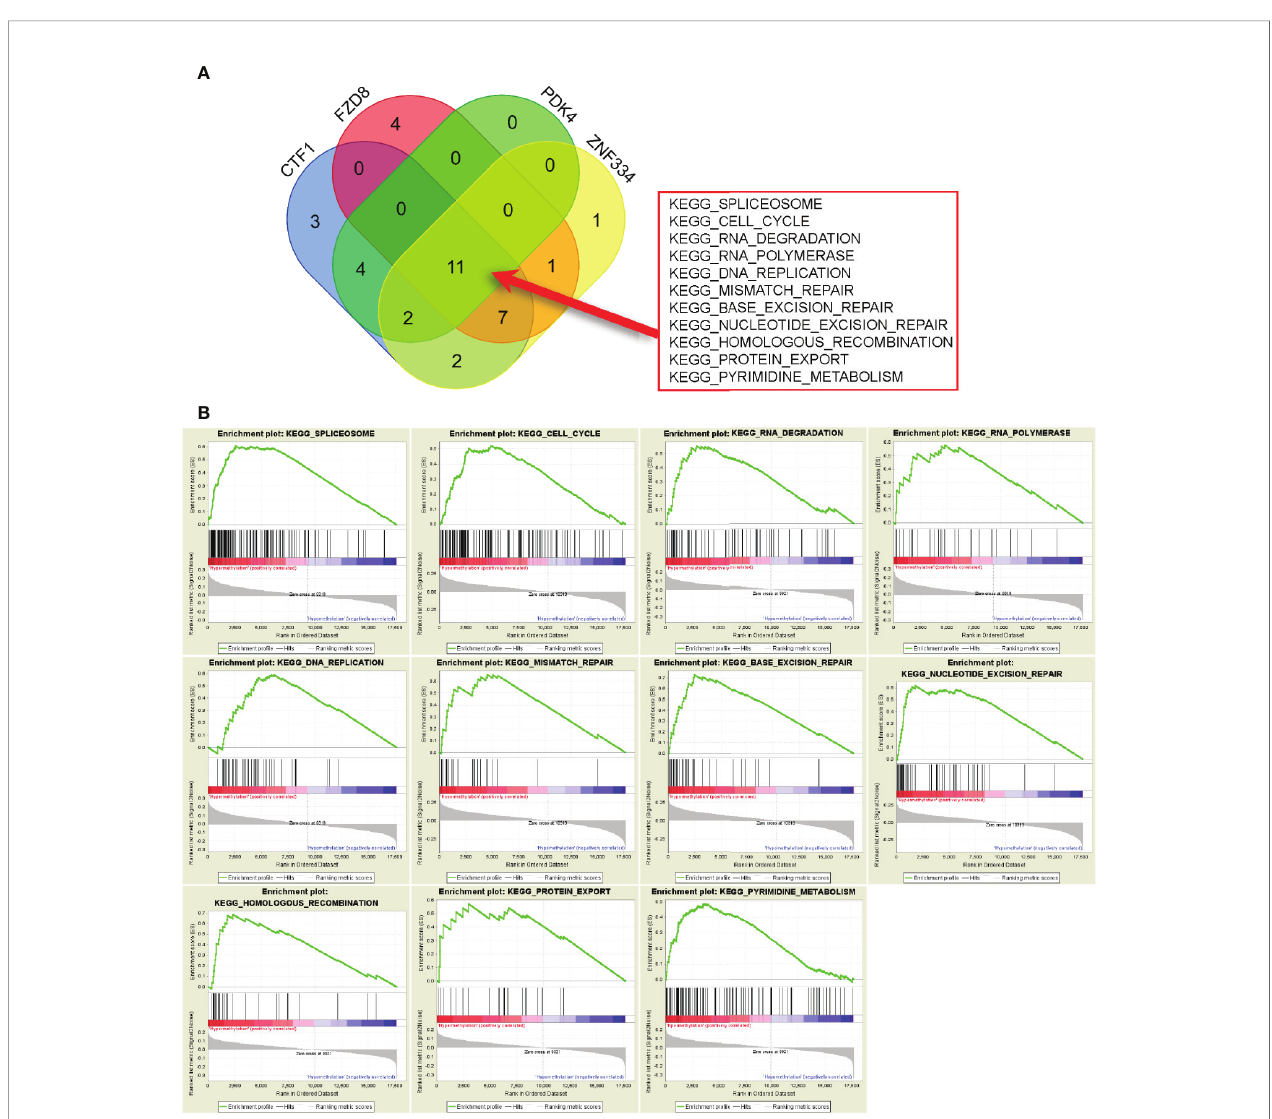
FIGURE 7 | Gene set enrichment analysis (GSEA) of prognosis-related MeDEGs. (A) Intersection of pathways enriched by hypermethylation of CTF1, FZD8, PDK4, and ZNF334 is shown in the diagram. (B) GSEA of PDK4 is shown as